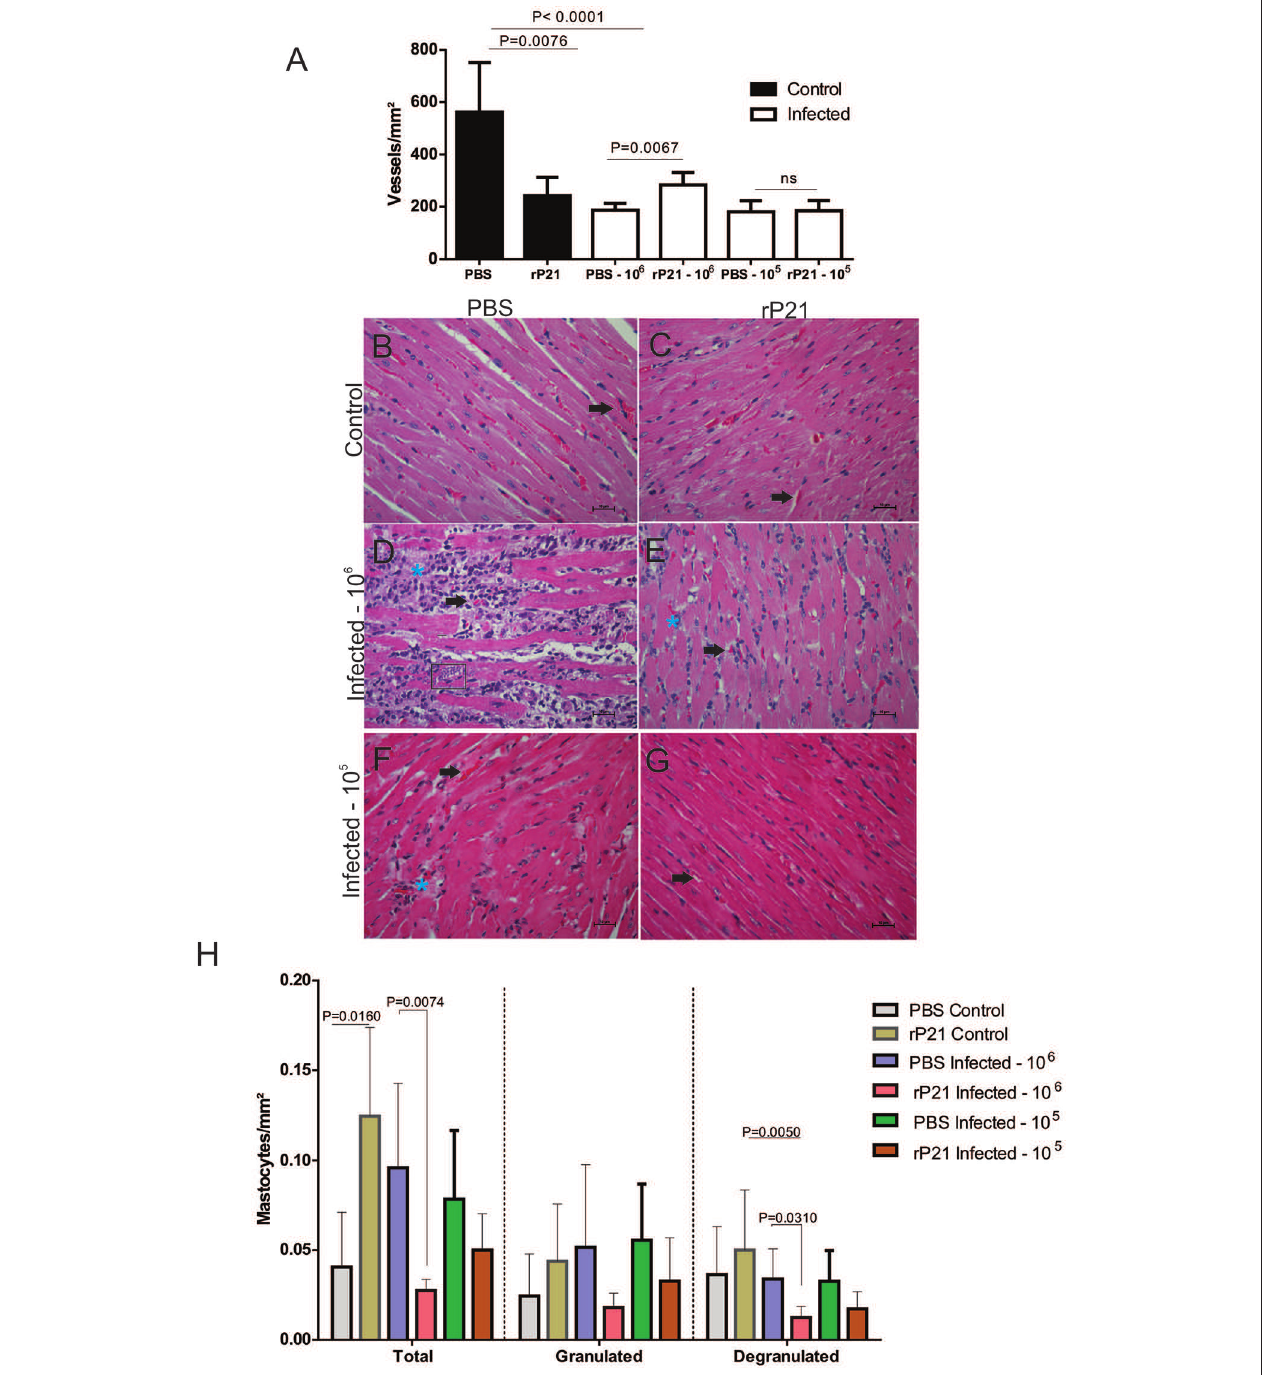
FIGURE 4 | rP21 preserves angiogenesis of the heart and decreases the presence of mast cells in animals infected with T. cruzi . (A) Treatment of uninfected mice with rP21 reduces the amount of cardiac blood vessels. However, in mice infected with 10 6 parasites and treated with rP21 (rP21-infected), the vascular architecture was preserved when compared to infected mice treated with PBS (PBS-infected). Representative images of H&E staining of heart tissues are shown with black points indicating blood vessels and blue asterisks inflammatory infiltrate areas (400 x magnification). (B) uninfected control and PBS treated. (C) uninfected animal treated with rP21. (D) infected with 10 6 trypomastigotes and PBS treated. (E) infected with 10 6 trypomastigotes and rP21treated. Infected animals with 10 5 trypomastigotes and PBS (F) and rP21 (G) treated. (H) rP21 decreases the recruitment of mastocytes in cardiac tissue from mice infected with 10 6 parasites. Data are expressed as mean ± standard deviation of experiments performed in triplicate. Significant differences were determined using Kruskal–Wallis and Dunn’s multiple comparisons test (a, h). Differences were considered significant when p < 0.05.